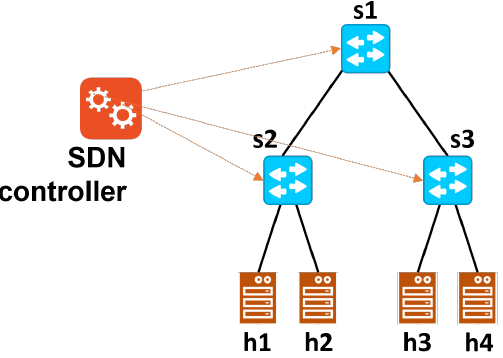
Figure 8. Simple tree topology for the SDN network for initial testing.